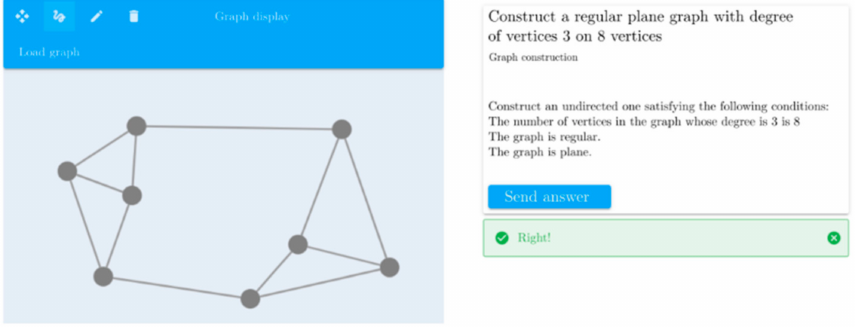
Figure 3. An example of a correct solution to the stated problem (the figure is taken from